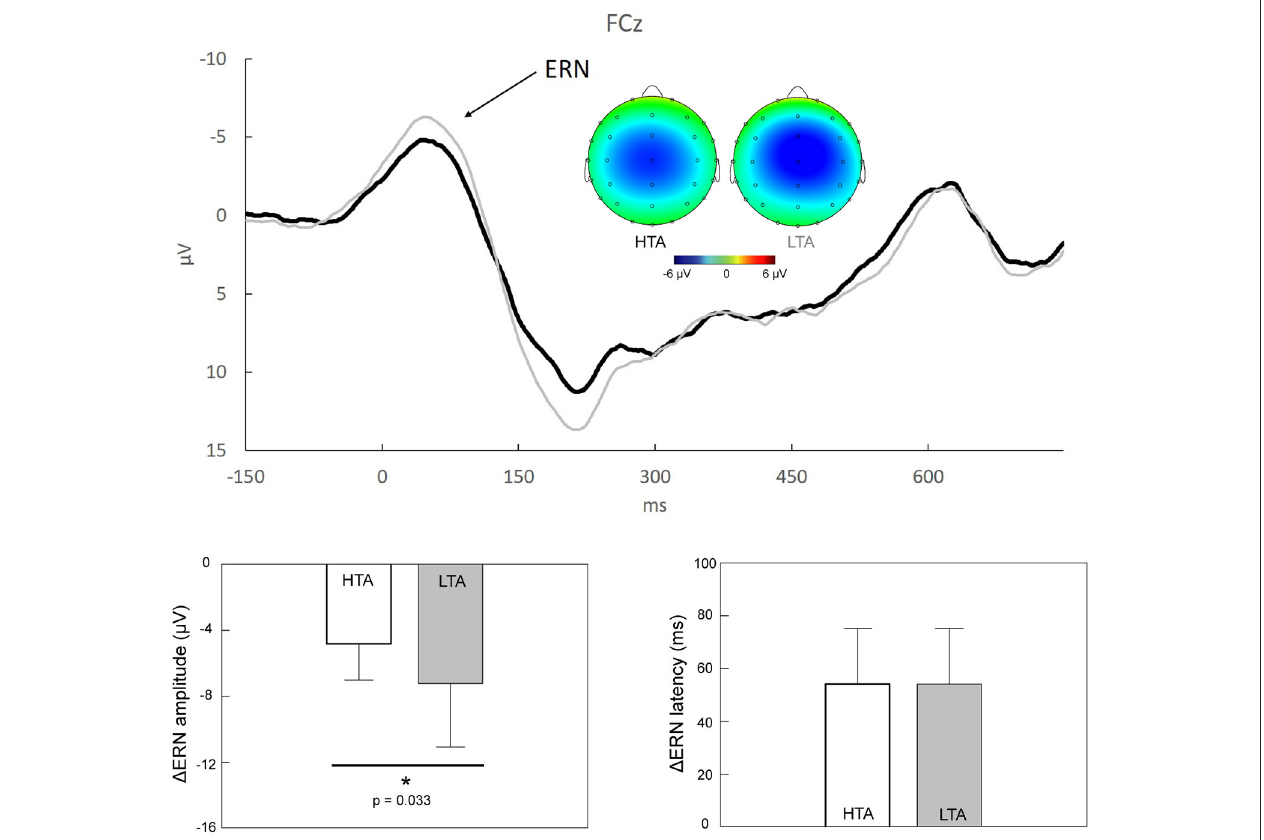
FIGURE 2 | Upper panel : Response-locked grand average 1 ERN (i.e., “error” minus “correct”) at FCz in individuals with high trait anxiety (HTA, black trace ) and those with low trait anxiety (LTA, gray trace ). The scalp topographies representing the peaks of 1 ERN in the HTA (23–63ms) and LTA (26–66ms) groups are also illustrated. Lower panel : Statistical results showed that, compared to individuals with LTA, those with HTA demonstrated a significant reduction of 1 ERN amplitudes. * p <